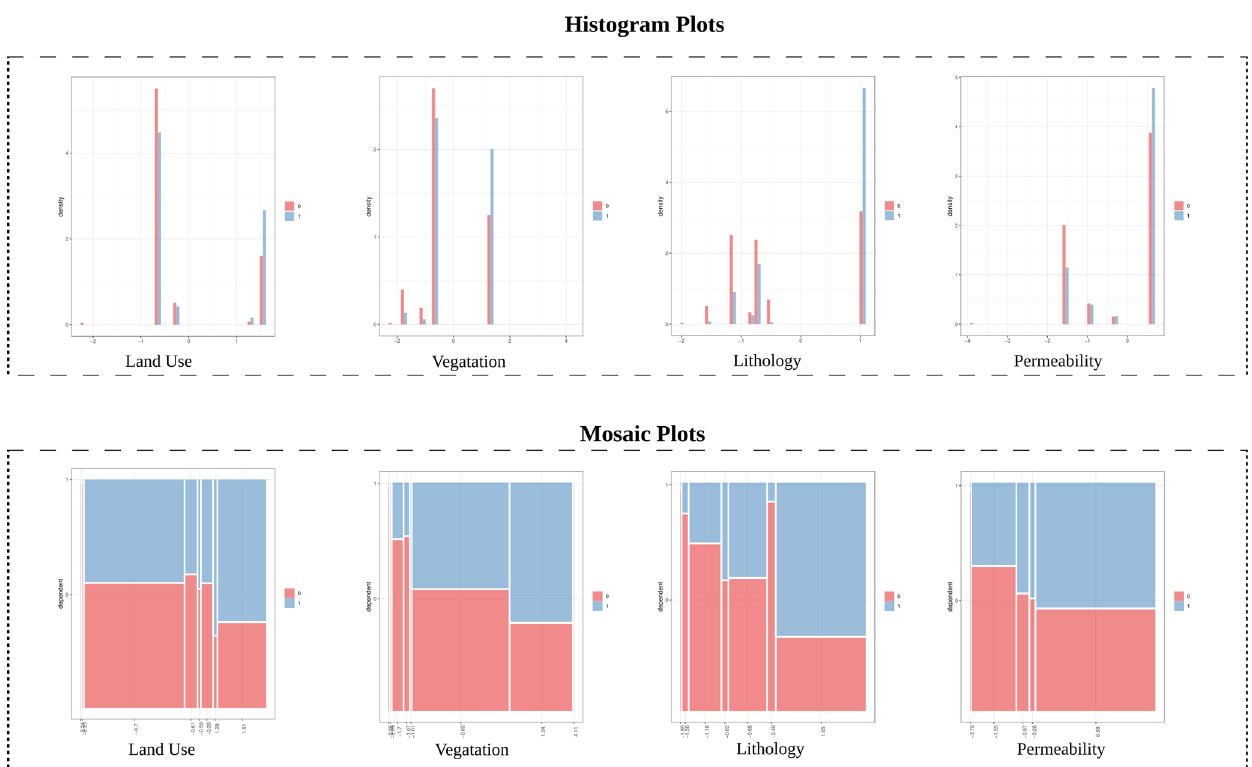
Figure 8. Histogram plots and mosaic plots for two categorical explanatory variables available in the Gipuzkoa study area.